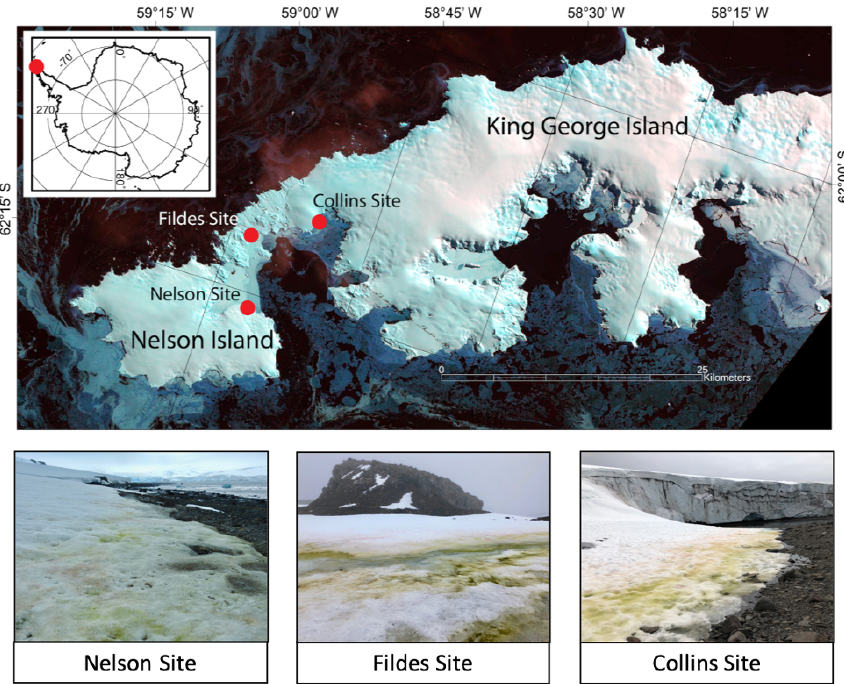
Figure 1. Map of sample locations and photos of sampling sites. Map images are from Landsat 8, acquired 29 September 2014, path 207, rows 103 and